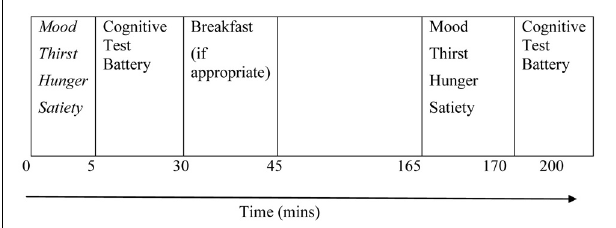
FIGURE 1 | Experimental